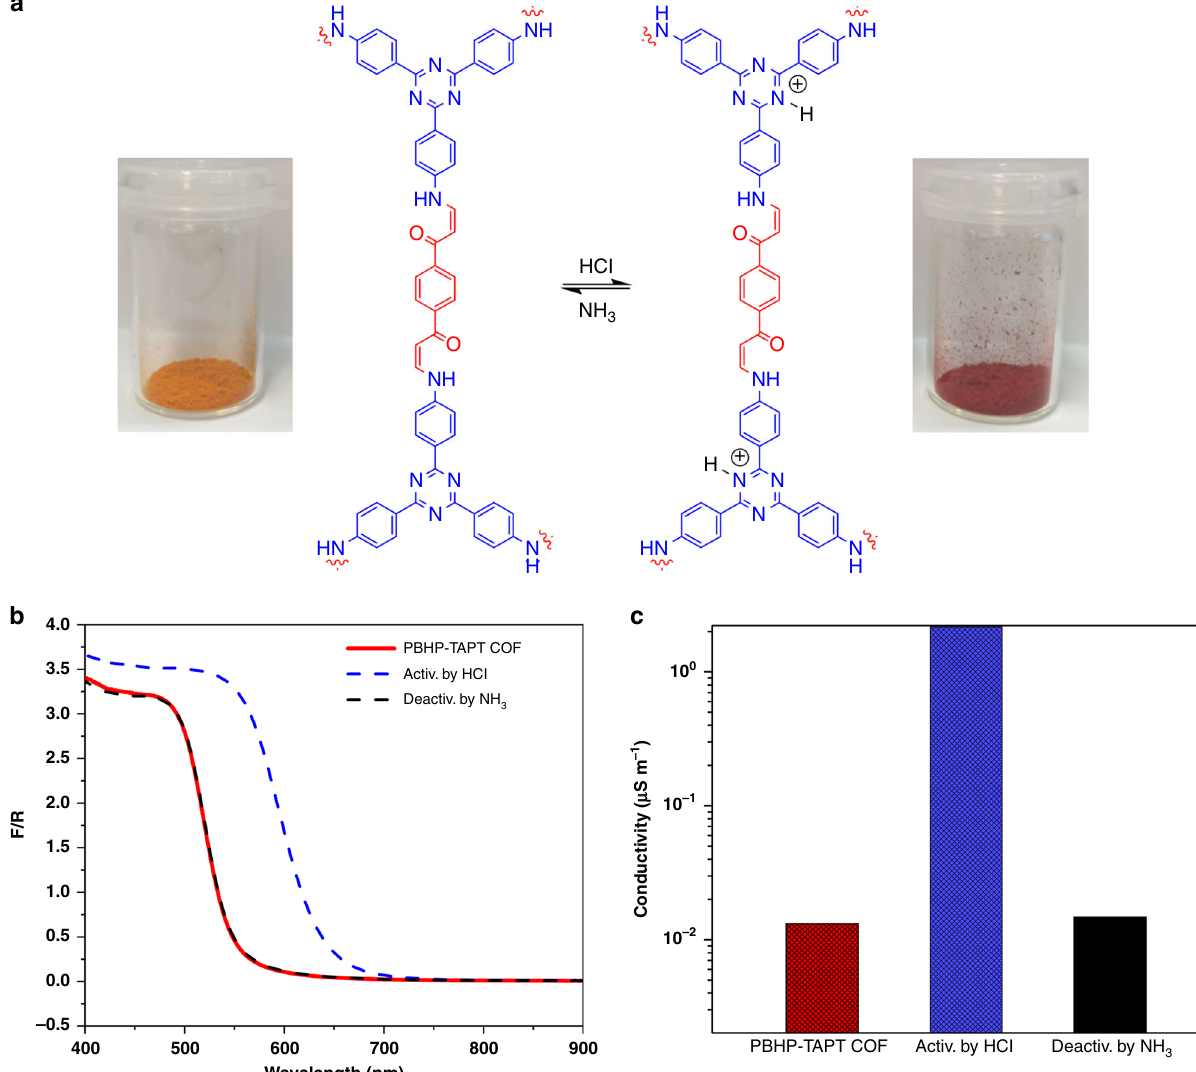
Fig. 3 Opto-electronic response of PBHP-TAPT COF. a Protonation and deprotonation of the triazine moieties with chemical triggers (HCl and NH 3 vapours): Pristine, bulk PBHP-TAPT COF orange powder (left) and the activated, red powder, after 2 – 3 s of exposure to HCl (right). b Solid-state UV/Vis spectra of pristine PBHP-TAPT COF (red), after activation with HCl vapours (blue; dashed and dotted line), and regeneration with NH 3 vapours (black; dashed line). c Electrical conductivity of pristine PBHP-TAPT COF (red), after activation with HCl vapours (blue), and regeneration with NH 3